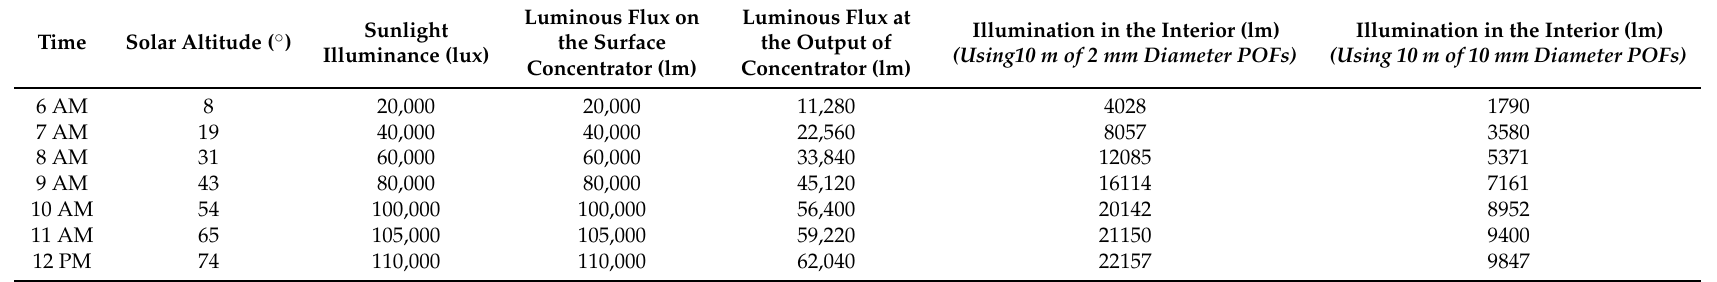
Table 3. Average illuminance at different times of the day and calculated luminous flux at the interior for the proposed